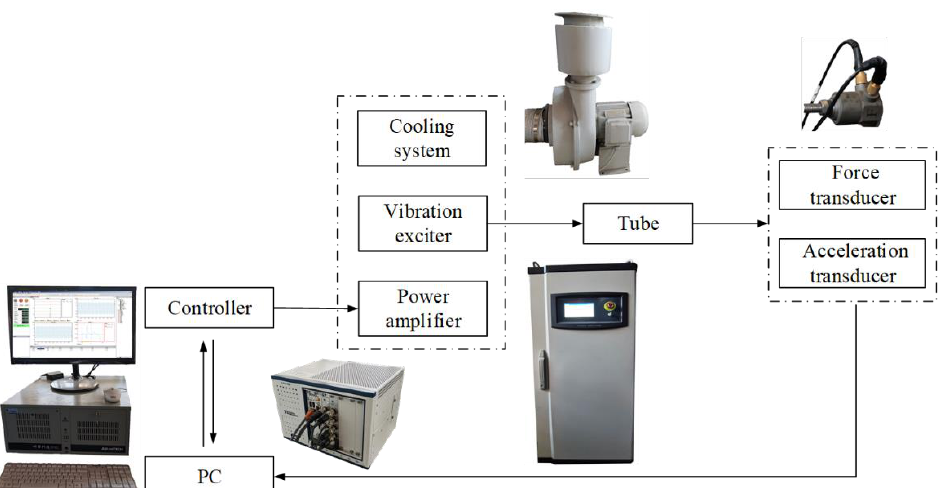
Figure 3. Flowchart of the control system.